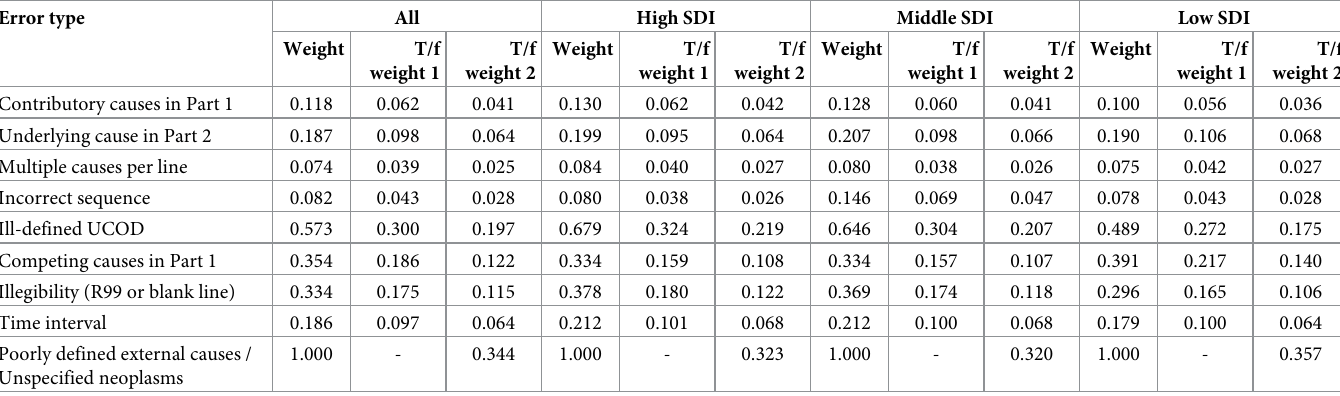
Table 2. Weights and transformed weights by error type and SDI